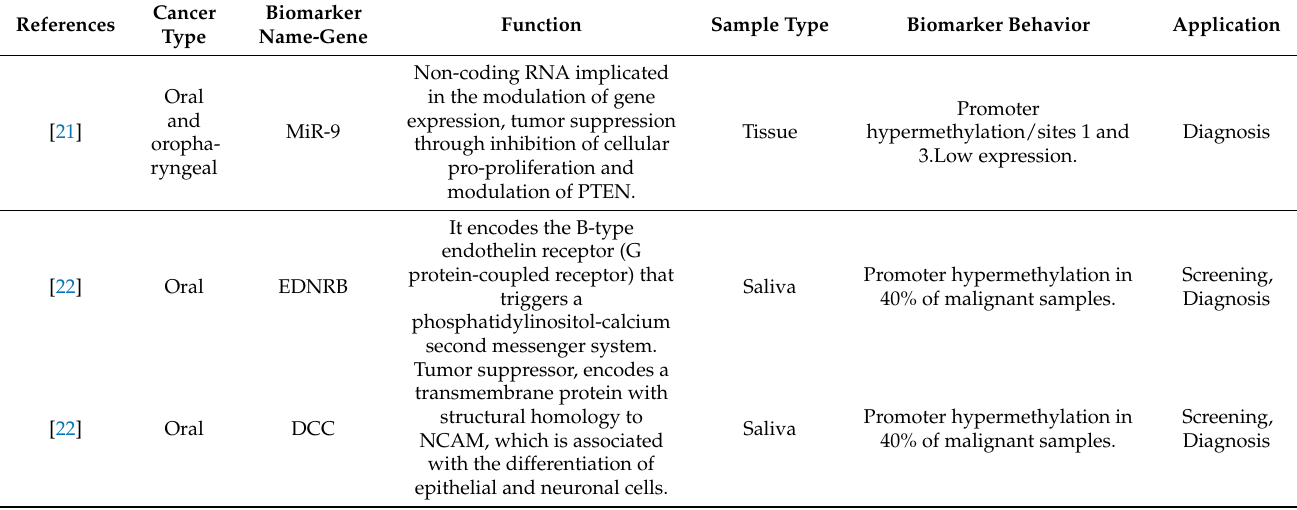
Table 1 includes a list of DNA methylation biomarkers with diagnostic potential [21–33]. Table 1. Diagnostic and Screening